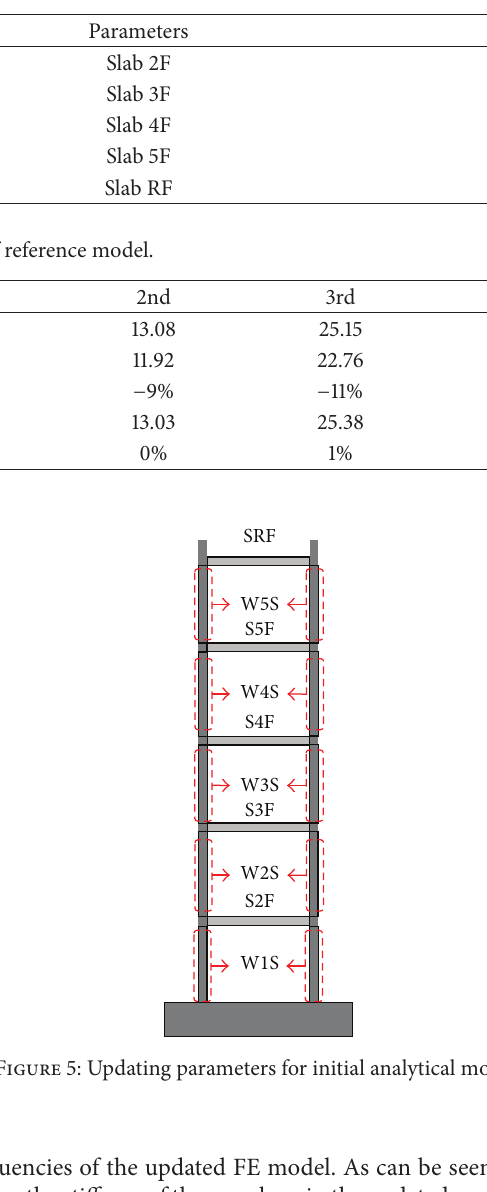
Table 2: Updating parameters for reference model.